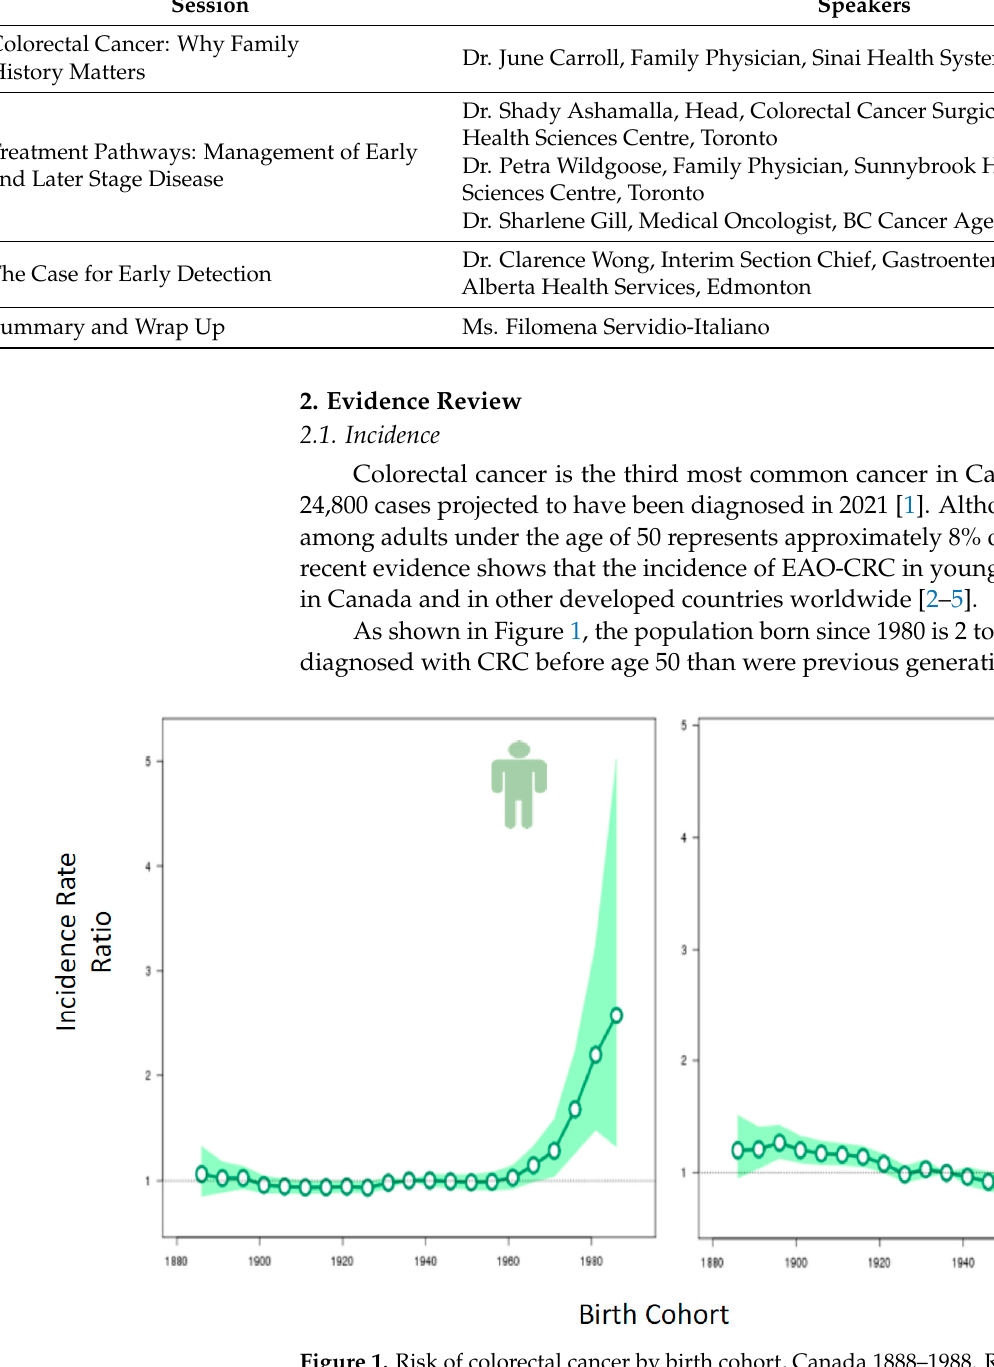
Figure 1. Risk of colorectal cancer by birth cohort, Canada 1888–1988. Reprinted with the permission from Ref. [6]. 2019.